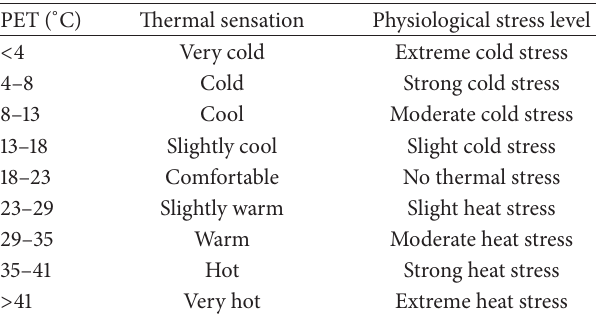
Table 1: Physiologically Equivalent Temperature (PET) for different grades of thermal sensation and physiological stress on human beings